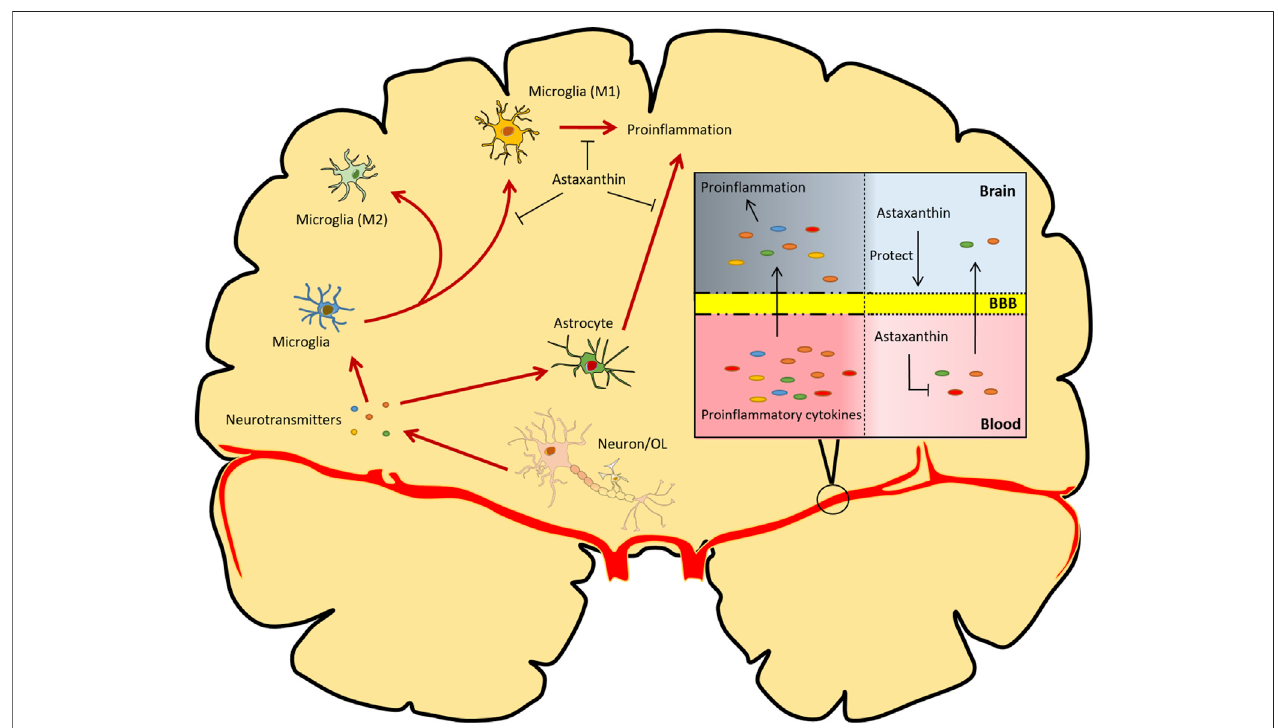
FIGURE 4 | Overview of the functional implications of astaxanthin in modulating neuroin fl ammation. Astaxanthin counteracts oxidative stress-induced damage to neurons and glial cells. Astaxanthin can also reduce the production of pro-in fl ammatory cytokines in the brain and retard the M1 polarization of microglia. Additionally, astaxanthin protects BBB integrity and inhibits theproduction and in fi ltration of in fl ammatory cytokines derivedfrom peripheral in fl ammation. OL, oligodendrocytes. The red arrows representprocesses ofneuroin fl ammation; the black arrows represent promotion, protection ortransportation; the lines with T-shaped ends represent